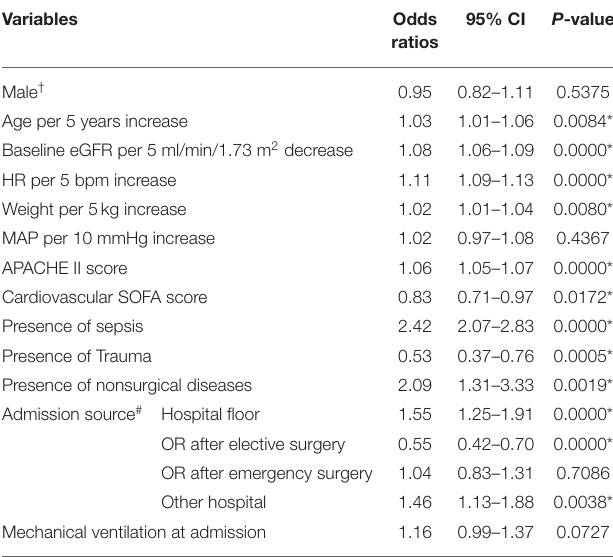
TABLE 2 | Univariate odds ratios of candidate predictive variables for the study outcome.